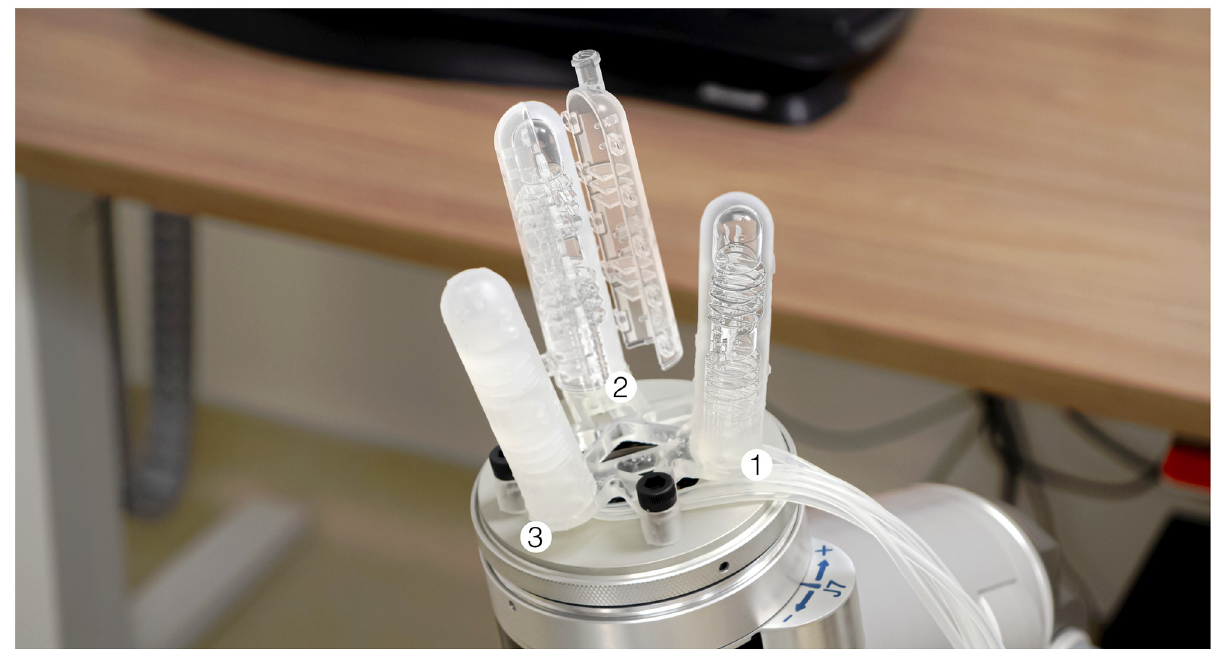
Fig 1. Negshell casting used for a three-finger soft robotic gripper. Pictured are three stages of negshell casting from the rightmost to the leftmost finger: 1. 3D-printed structural and negshell cores, 2. The cores placed in 3D-printed molds to be injected with silicone rubber, and 3. A completed finger ready to be